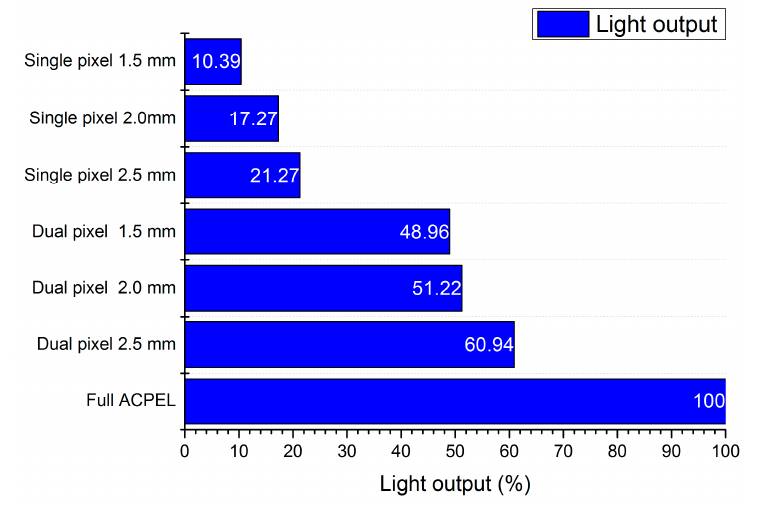
Figure 3. Light output of the ACPEL devices.